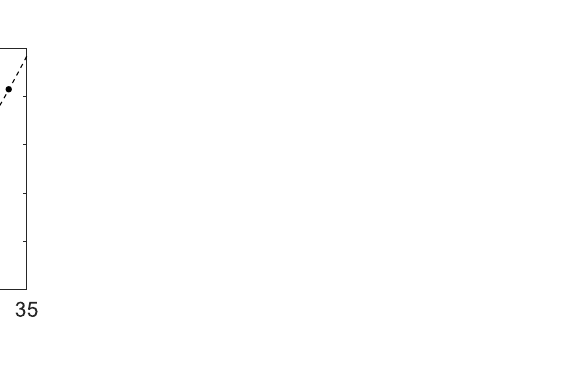
Figure 11. The measured DCR trend from the literature fitted by the theoretical equation [40]. The measured and fitted data are shown as dots and a dashed line,